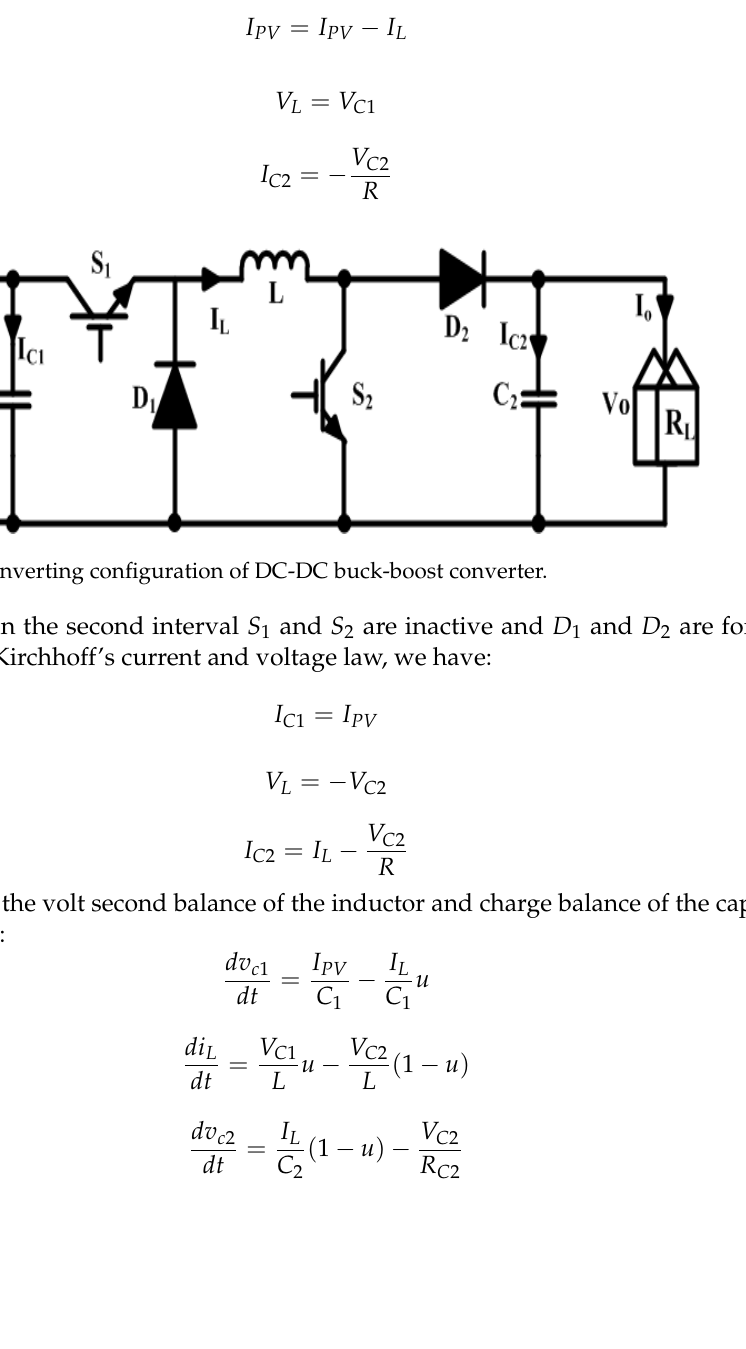
Figure 7. Reference voltage generation using various NF techniques.